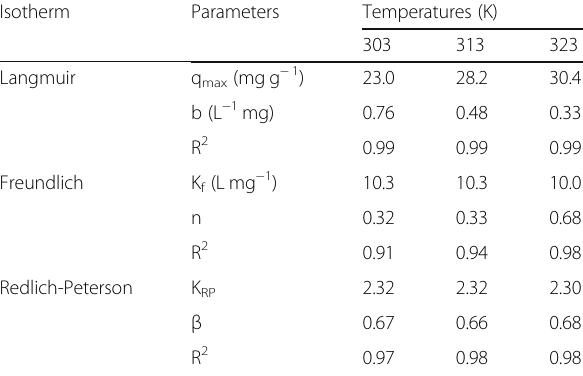
Table 1 Adsorption isotherm parameters at various temperatures Isotherm